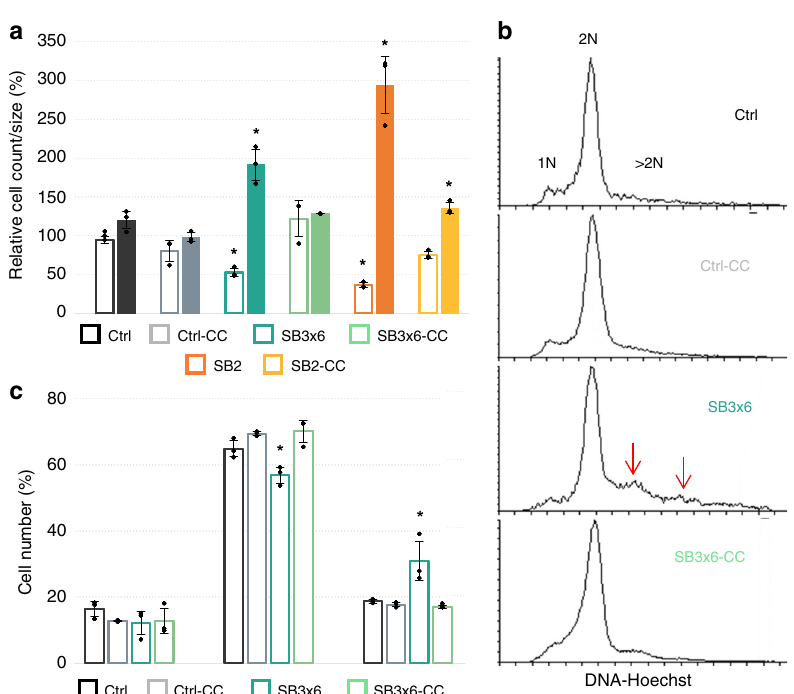
Fig. 5 Cell size distribution in silenced and control pIZ-plasmid cultures. a Left: phase contrast micrographs of Ctrl control, SB3×6 and SB2 slaB- silenced (left) and complemented cultures (-CC) (right). Scale bar: 10 µ m. Right upper panel: scanning electron micrographs (gold coated) of slaB- silenced SB3×6 and Ctrl; scale bar: 5 µ m (magni fi cation × 2700). Right lower panel: Transmission Electron micrographs (magni fi cation: × 6000) of thin sections (contrasted with Uranyl acetate 2%, and Lead citrate 2%) of slaB- silenced SB3×6 (left) and control Ctrl cultures (right); scale bar: 1 µ m. b Cell size distribution of Ctrl, SB3×6, and SB2 cultures (OD 600 = 0.1). Bars in the graph represent the samples in the following order from left to right: Control (dark gray); SB3×6 (petrol); SB2 (orange). Cell sizes were measured using MicrobeJ software on phase contrast micrographs ( n > 300, different biol. replicates). c FSC-histogram (Forward scatter, fl ow cytometry, created with Flowing Software 2.5.1 ) of silenced and control cultures sampled at OD 600 = 0.1 ( n = 10,000 per biol. replicate). Bar chart represents percentage of cells in population exhibiting “ small ” , “ average ” and “ large ” size (size sections de fi ned according to Ctrl histograms). Bars in the graph represent the samples in the following order from left to right (in every section): Control (dark gray); control-CC (light gray); SB3×2 (green); SB3×6 (petrol); SB3×6-CC (light petrol); SB2 (orange); SB2-CC (yellow). Error bars, mean ± SD (three biol. replicates). Asterisks indicate signi fi cant differences to Ctrl (two-tailed t test, n = 3, p ≤ 0.009) d Salt-stress experiment. Violin plot depicts decrease and increase of abundances of speci fi c cell sizes of untreated (M) pIZ-plasmid SB3×6 and Ctrl cultures ( n = 50 cells per replicate and condition), and upon 100 m M and 200 m M salt treatment (treatment upon salt additio n = 45 min, 77 °C, agitating), respectively. Plots represent the samples in the following order from left to right (in each treatment): Control (gray); SB3×6 (petrol). Cell size differences were measured as in b ). Source data are provided 70